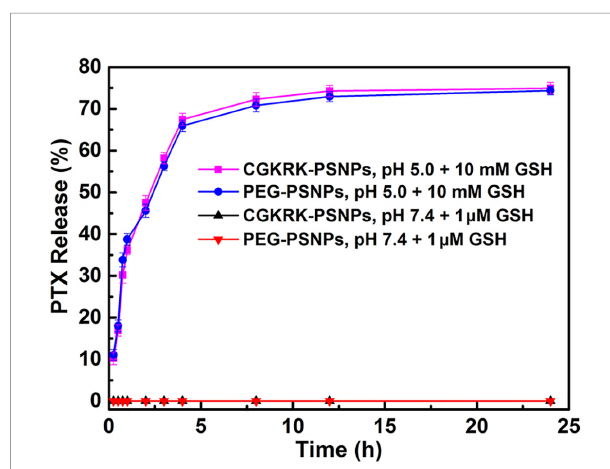
FIGURE 4 | Reduction-triggered PTX release from CGKRK-PSNPs with 1 m M GSH or 10 mM GSH (n = 3).